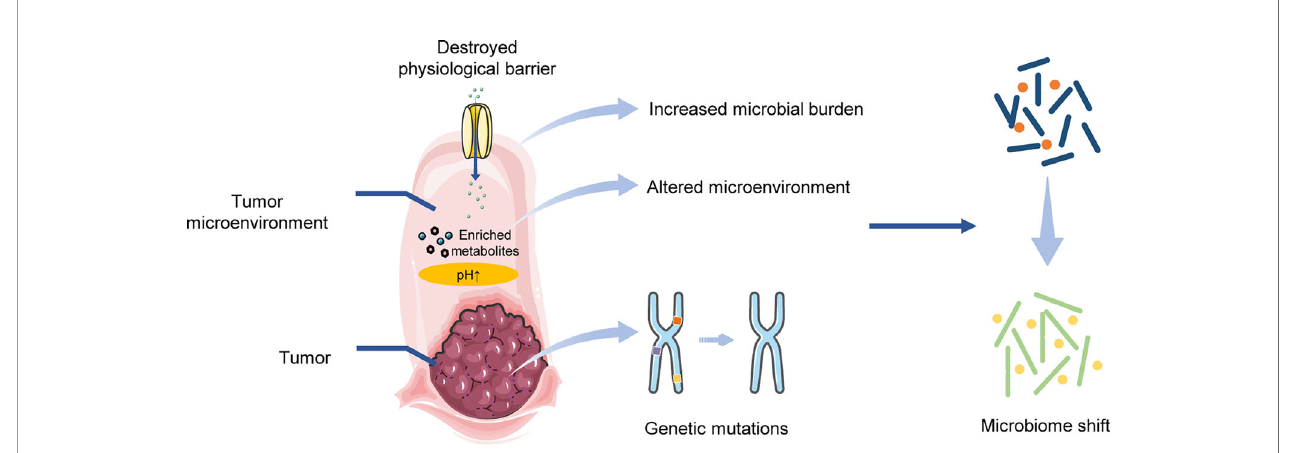
FIGURE 2 | Tumor progression affects the microbial